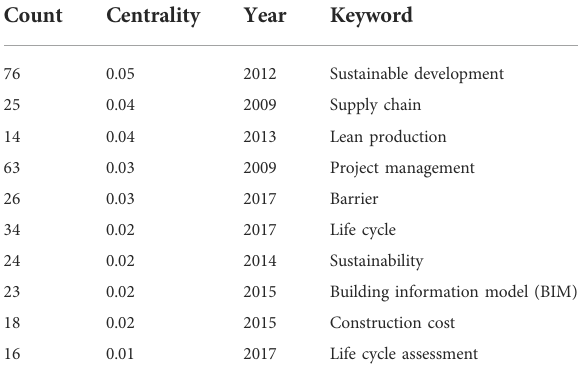
TABLE 4 Top centrality for keywords related to management.